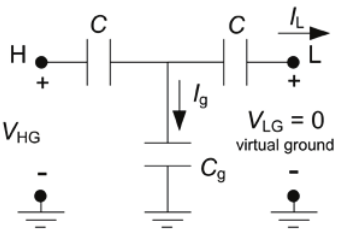
Fig.3: Simplified equivalent circuit when C is small enough for its impedance to predominate over that of the electrodes and the body at the measurement